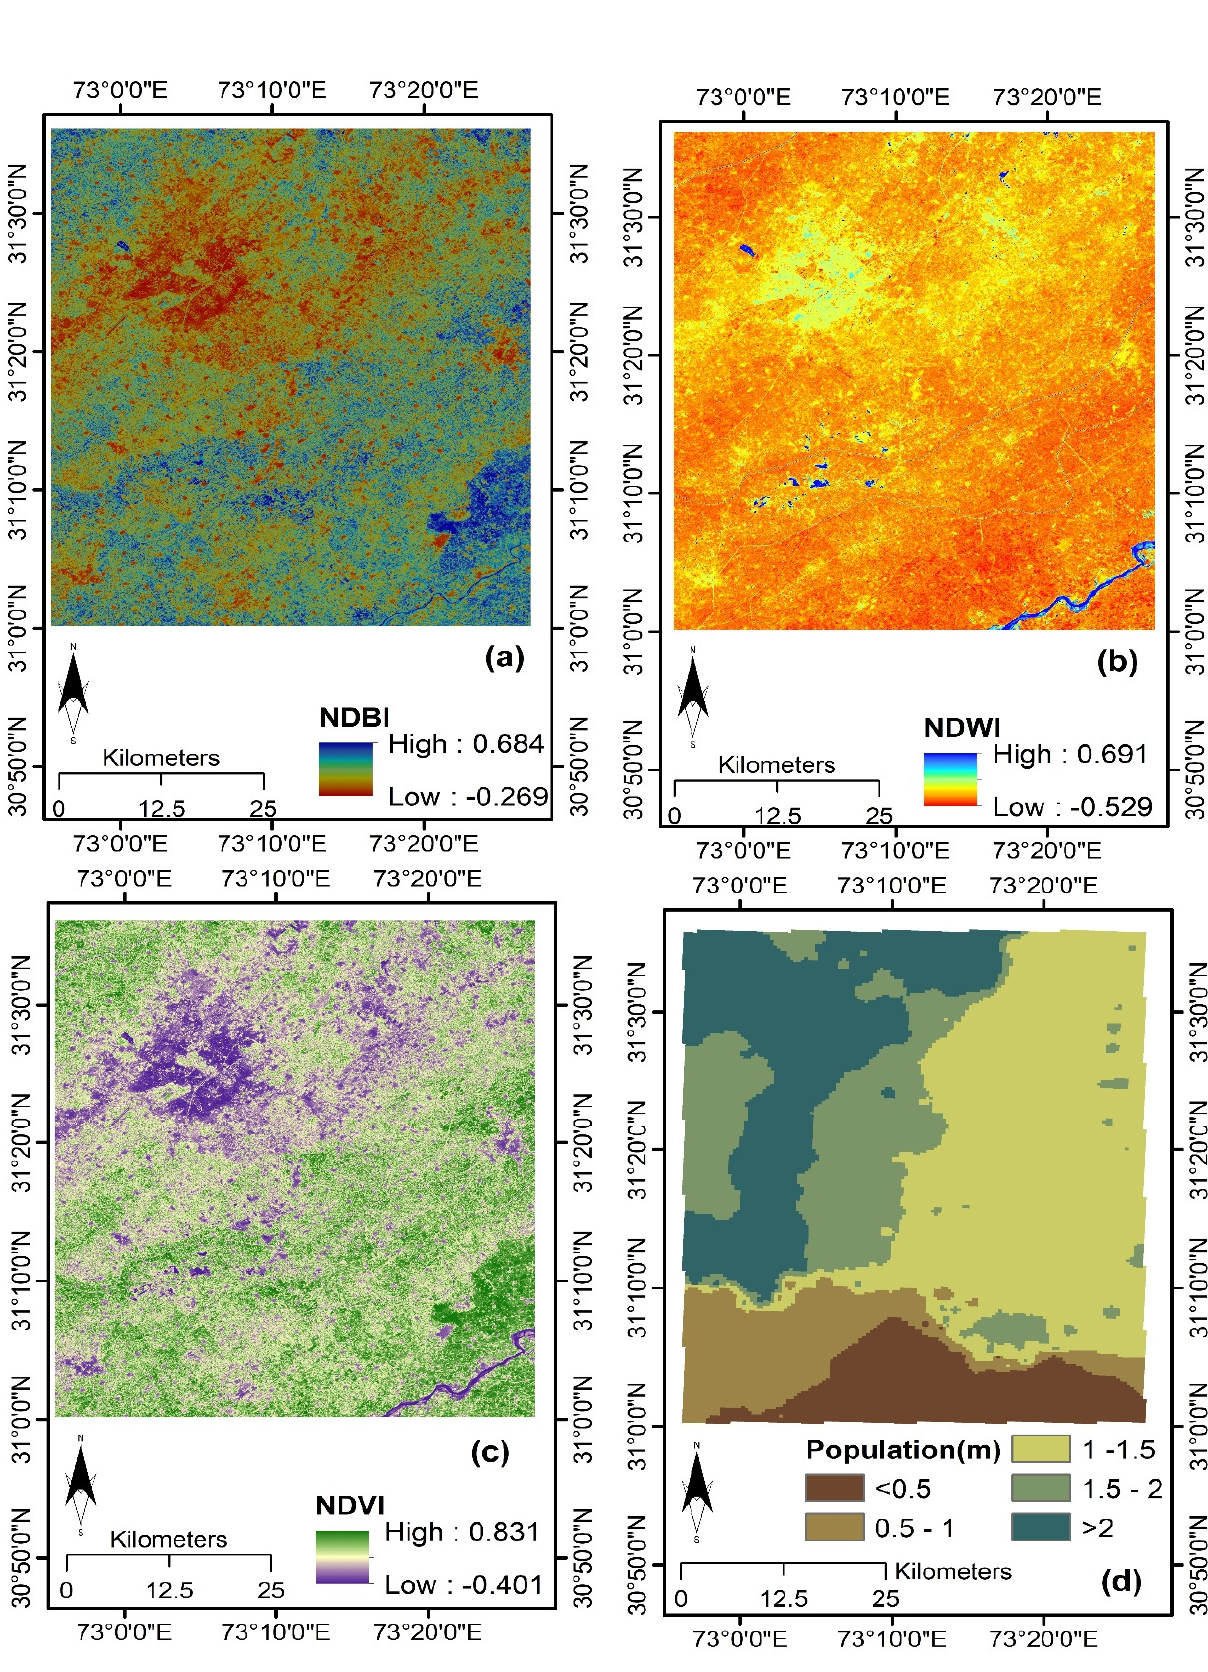
Figure 4. Normalized RS Indices and population distribution map of the study area. ( a ) NDBI, ( b ) NDWI, ( c ) NDVI, ( d ) Population.